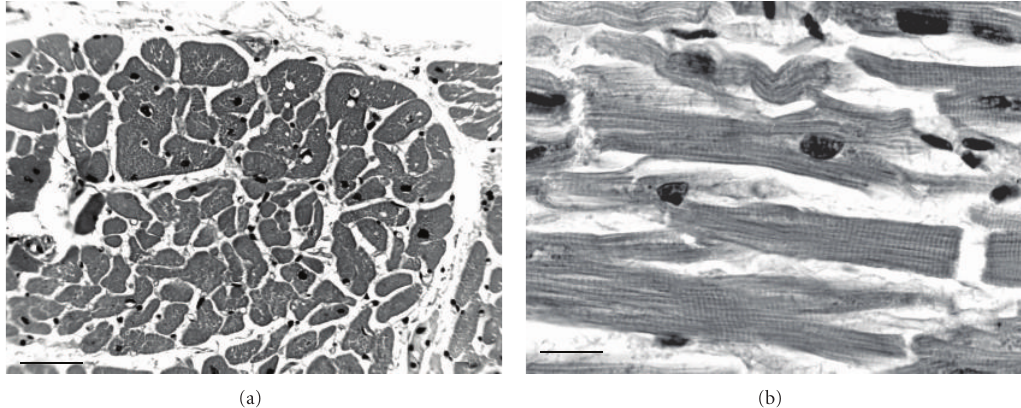
Figure 1: Cross-sectional (a) and longitudinal (b) planes of cut as assessed in the first 34 cases. H&E, bars = 30 μ m.